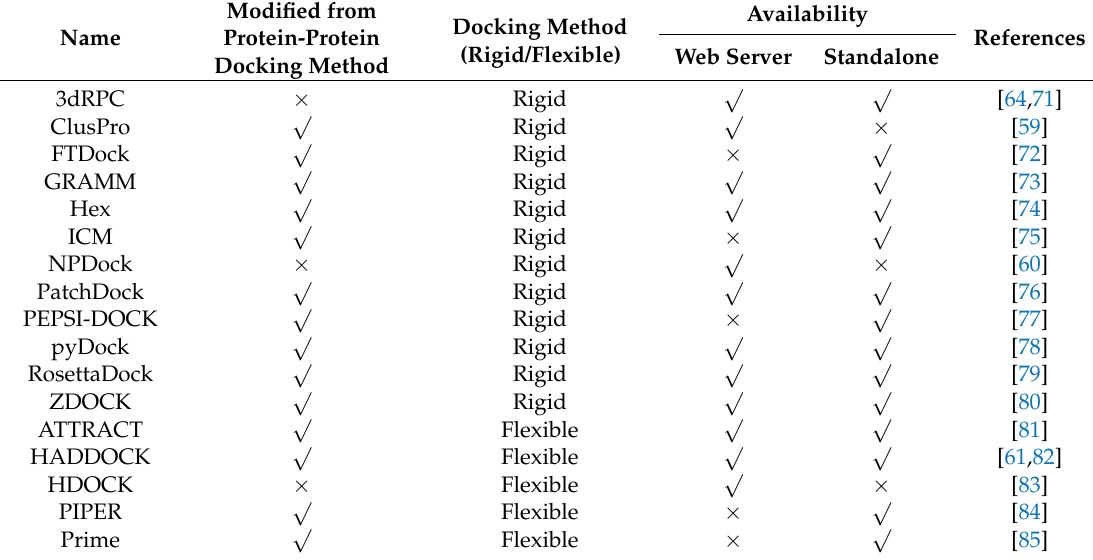
Table 1. Comparison of existing RNP docking methods. The majority of these methods are modified from existing protein-protein docking methods. The type of docking algorithm (rigid or flexible) and their availability (web server and/or standalone) are